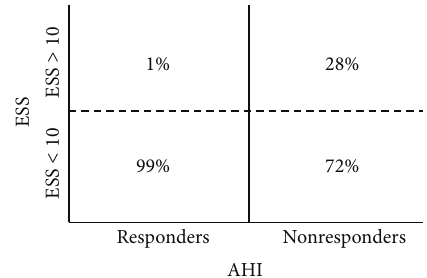
Figure 2: Comparison between postoperative ESS and postopera- tive AHI.